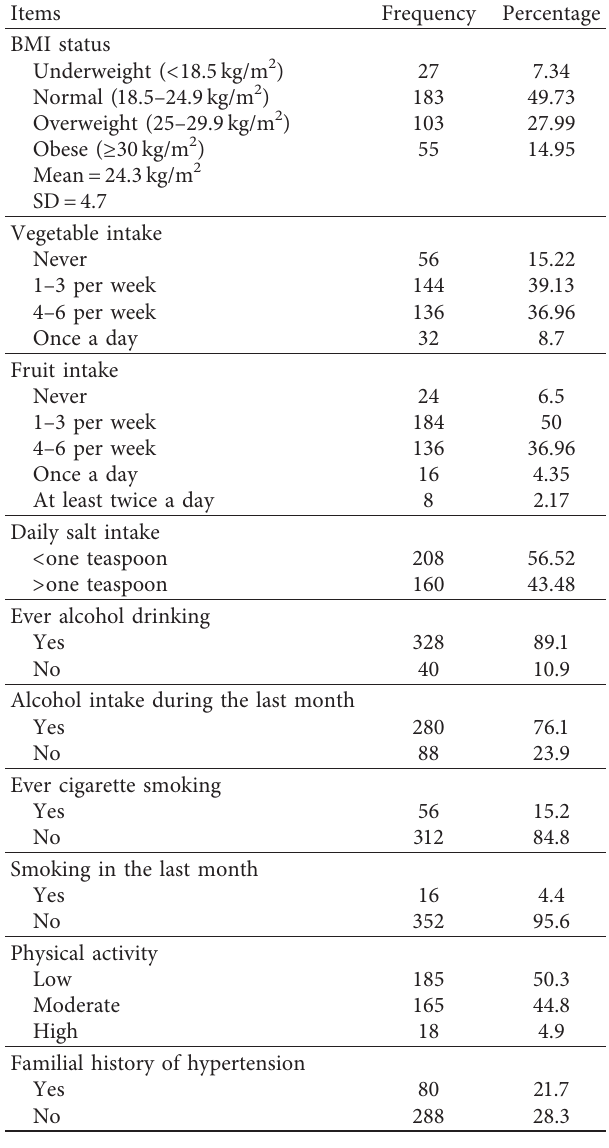
Table 3: Physical measurements and behavioral characteristics of bank employees in metropolitan cities of Amhara Regional State,